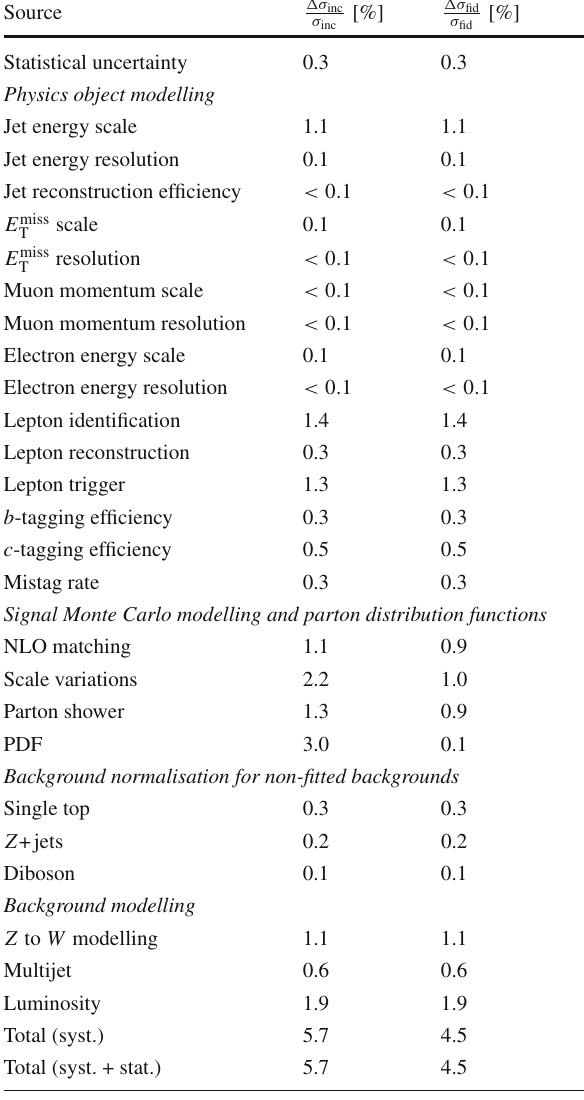
Table 4 Breakdown of relative uncertainties in the measured inclu- sive and fiducial t ¯ t cross-sections. The total uncertainties contain all considered